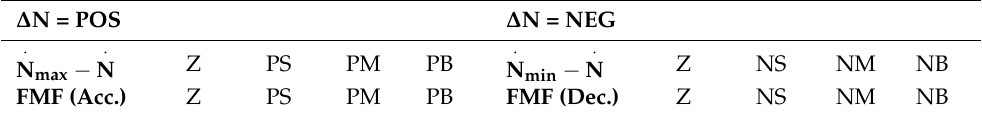
Figure 9. Third input membership functions. Table 5. Fuzzy rules for MADLL